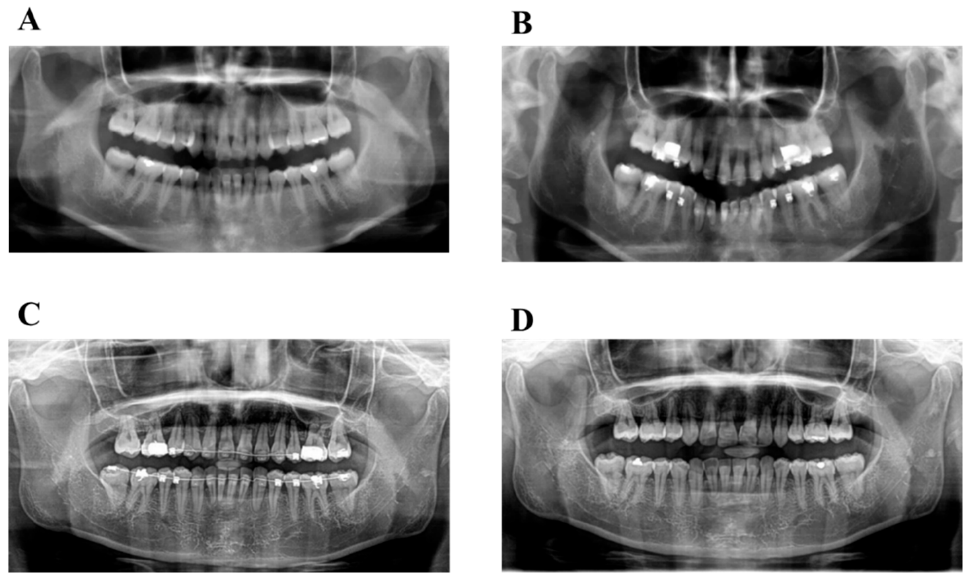
Figure 2. The progress panoramic radiograph of severe root resorption. ( A ): Pretreatment, ( B ): 1 year after start active treatment, ( C ): 2 years after start active treatment, ( D ): Post-treatment (2.5 years after start active treatment).